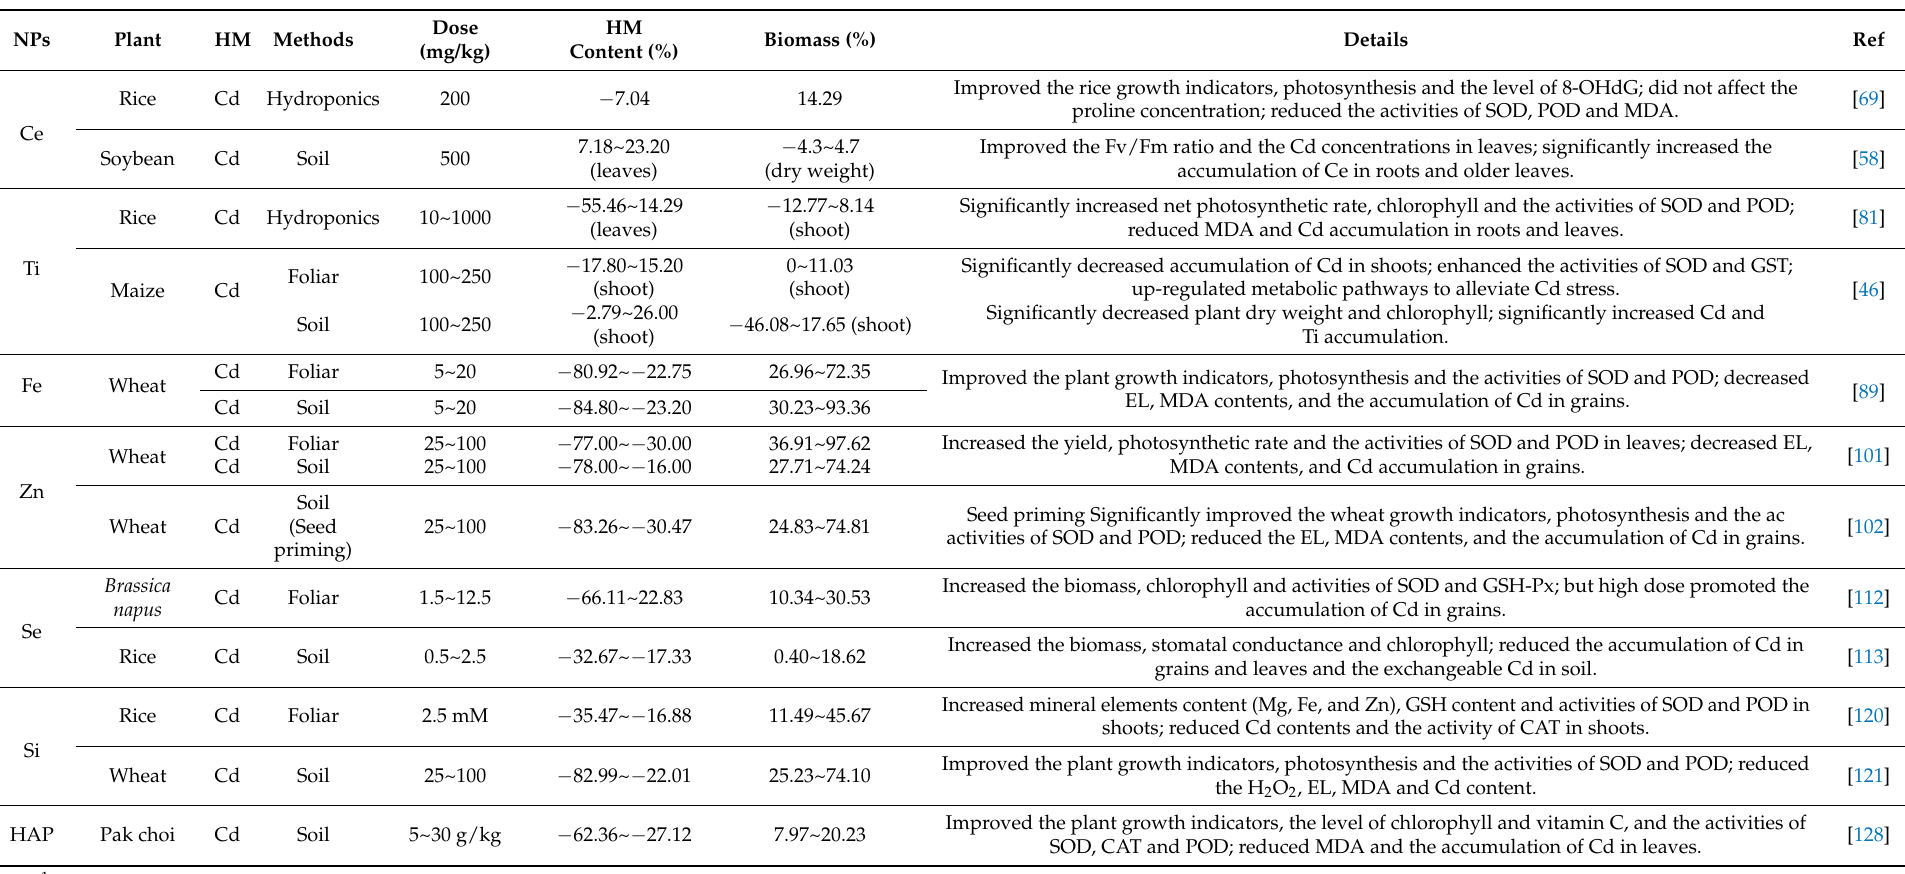
Table 1. Effects of different NPs on the plants under Cd